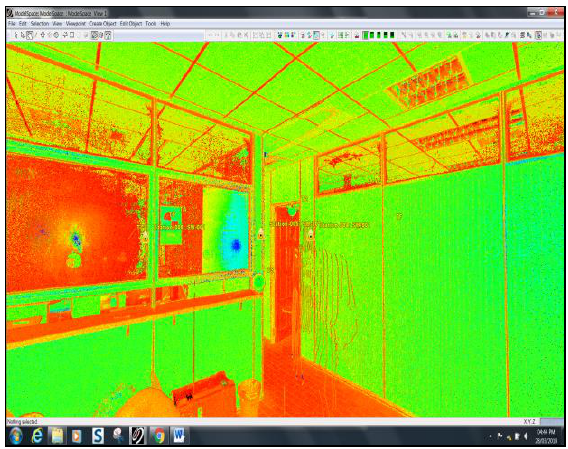
Figure 11. Result after completing TLS data registration